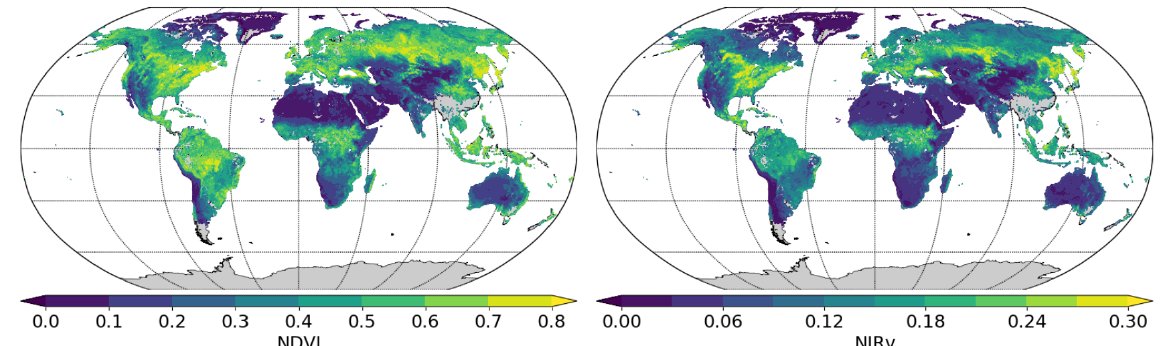
Figure 11. Global composites of NDVI and NIRv derived from the TROPOSIF product for the 8–15 July 2019 time period. Data are gridded in 0.2 ◦ grid boxes. A cloud fraction threshold of 0.1 is applied for cloud screening.